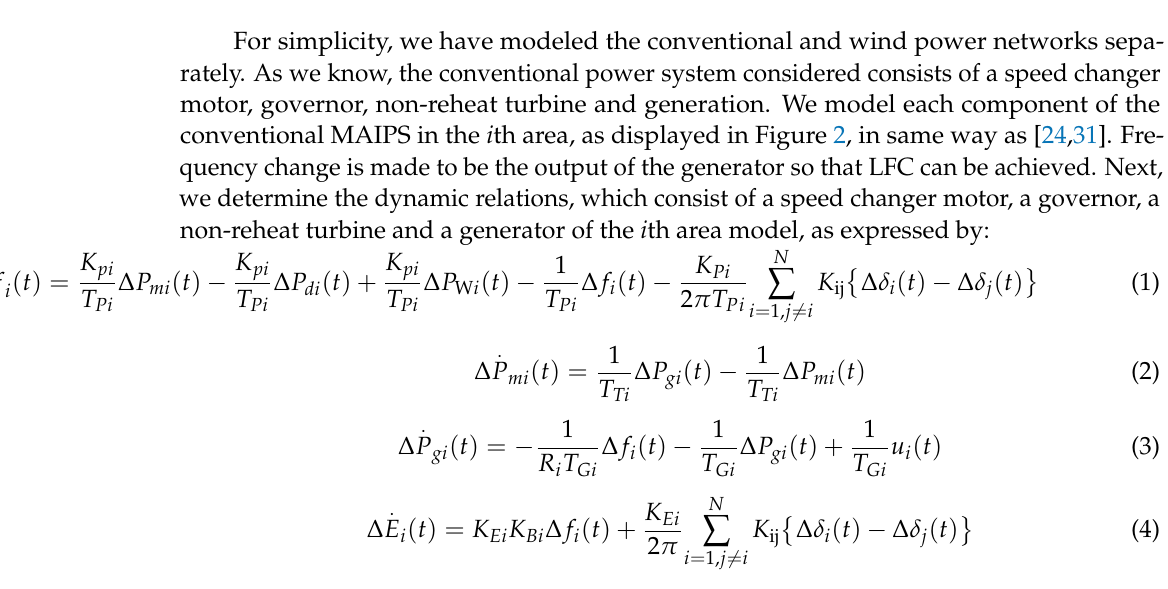
Figure 2. Schematic block diagram sketch for i th area network, including a wind farm.